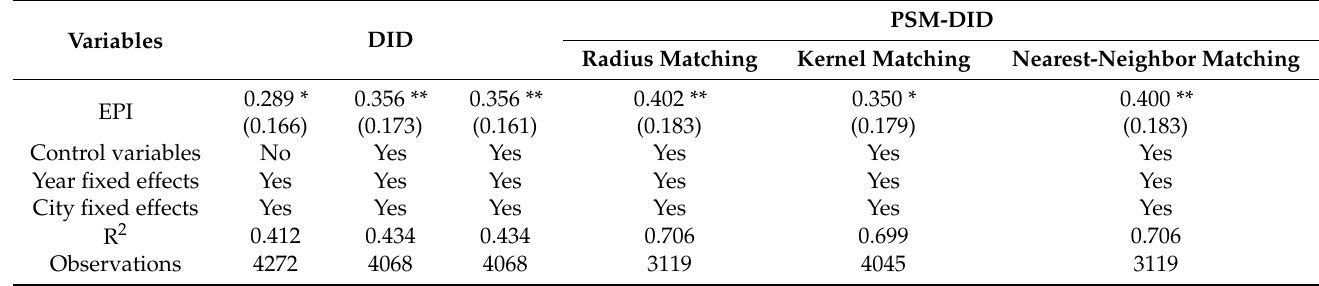
Table 2. Average treatment effect of the EPI on